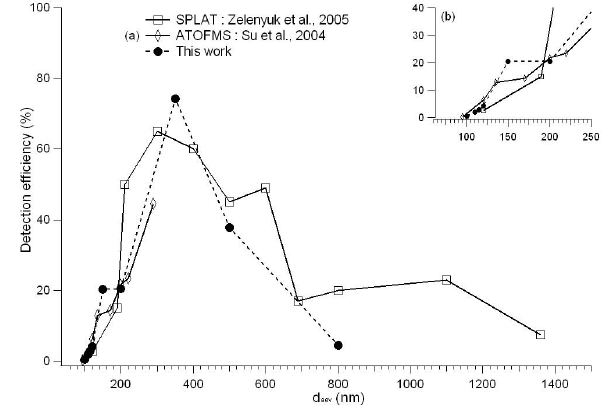
Fig. 5. (a) DOP particles detection efficiency for SPLAM instrument (black circles) and PSL particles detection efficiency for SPLAT (Zelenyuk et al., 2005) (open squares) and ATOFMS (Su et al., 2004) (open diamond) instruments plotted as a function of vacuum aerodynamic diameter, (b) close up of the graph (a) between 50 and